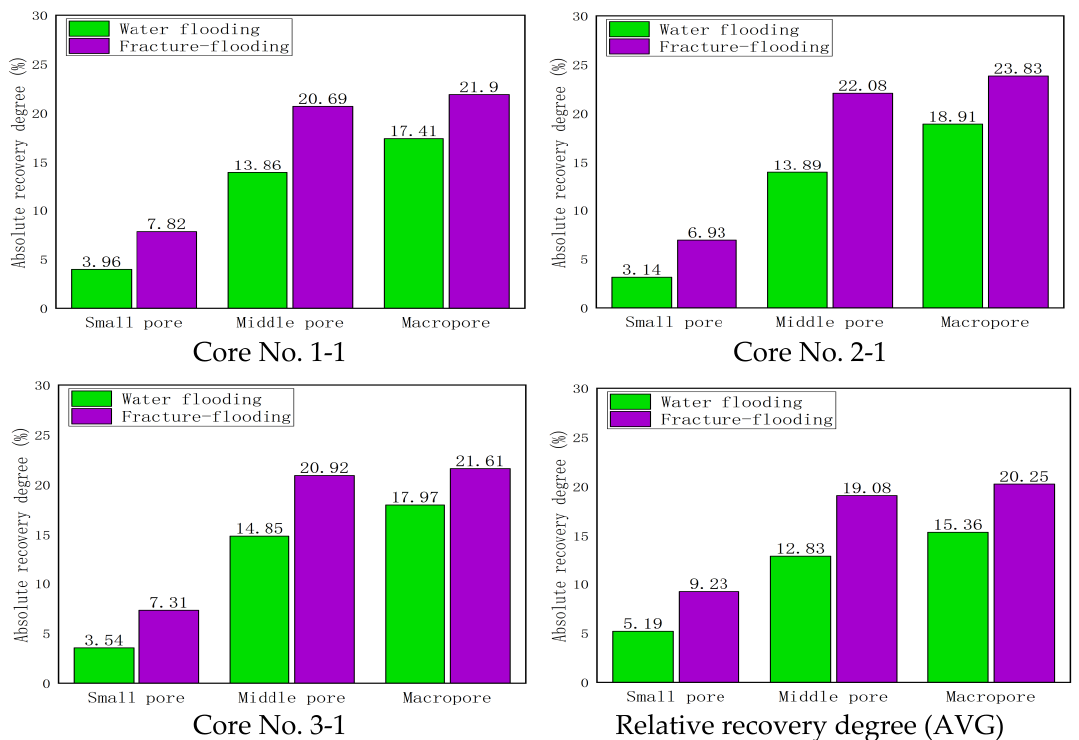
Figure 7. Absolute recovery degree under different displacement conditions. Table 2. Recovery degree table of different pore areas of T 2 spectrum under different displacement states.